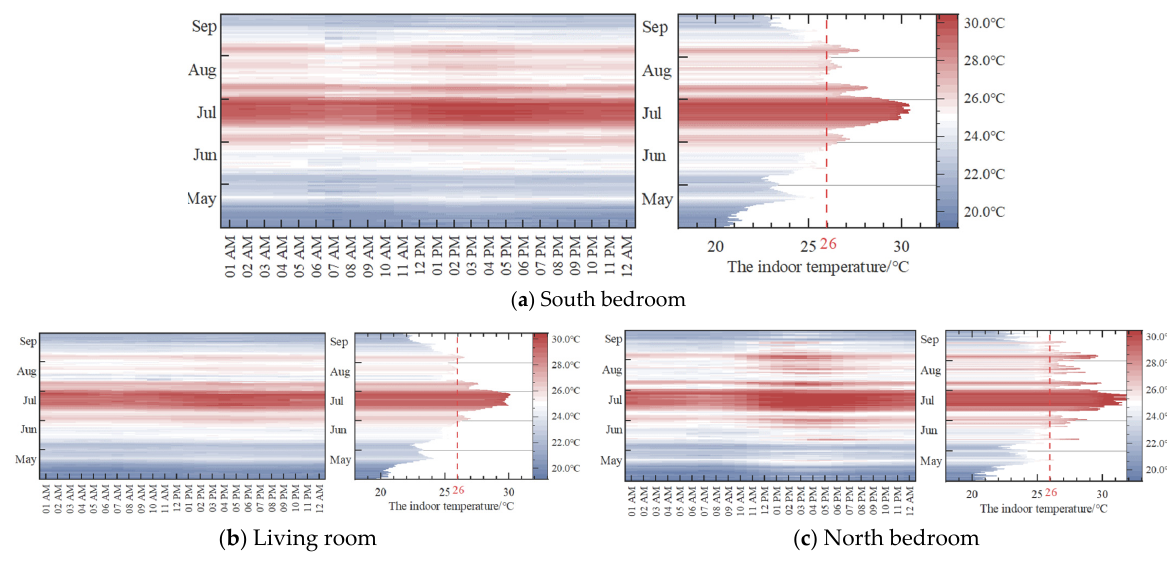
Figure 7. Measured indoor temperature in temperature degree bands for three rooms from May to September in 2021.